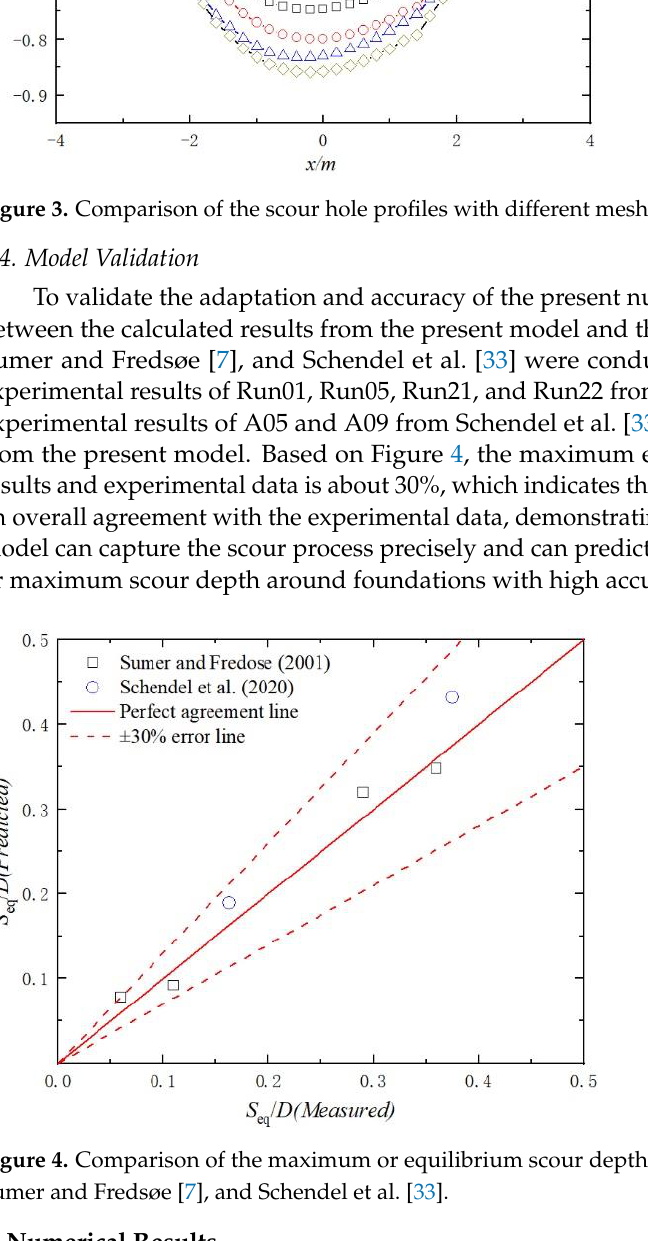
Figure 3. Comparison of the scour hole profiles with different mesh grid sizes.